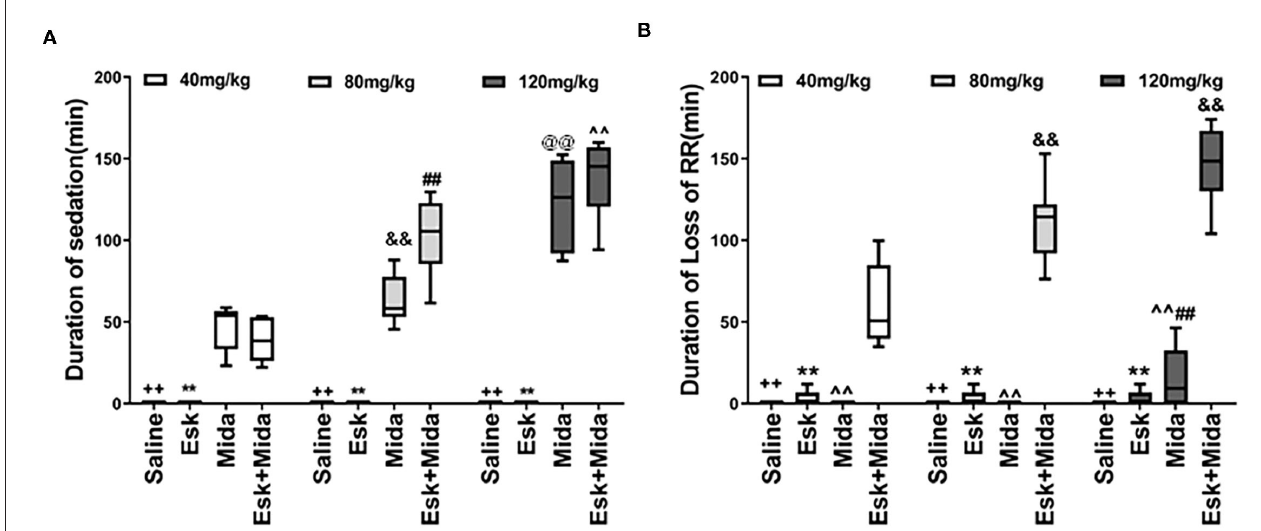
FIGURE 2 | Duration of sedation and loss of RR. (A) Duration of sedation. ++ P < 0.001, compared to Mida and Esk + Mida groups. ** P < 0.001, compared to Mida and Esk + Mida groups. ## P < 0.01, compared to Esk + Mida40. ∧∧ P < 0.01, compared to Esk + Mida40 group. && P < 0.01, compared to Mida40 group. @@ P < 0.01, compared to Mida80 and Mida40 groups. (B) Duration of RR. ++ P < 0.01, compared to Esk + Mida groups. ** P < 0.01, compared to Esk + Mida groups. ∧∧ P < 0.01, compared to Esk + Mida40, Esk + Mida80 and Esk + Mida120 groups. && P < 0.01, compared to Esk + Mida40 groups. ## P < 0.01, compared to Mida40 and Mida80 groups.